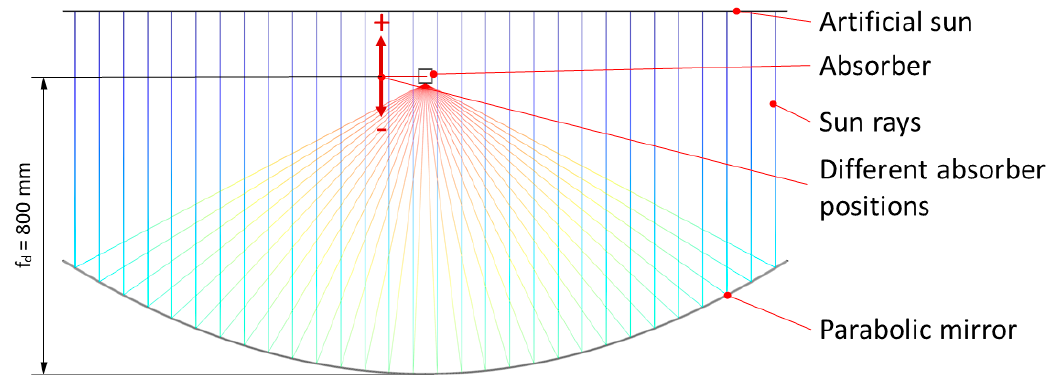
Figure 8. Simulation setup of the FEM ray tracing simulation for receiver placement optimization. High Concentration Setup